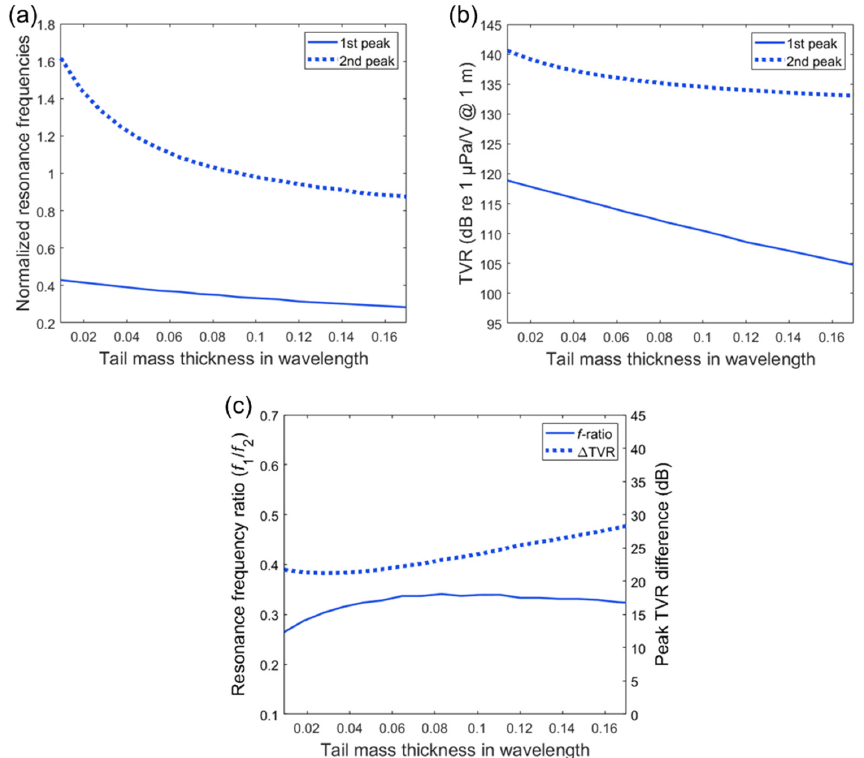
Figure 6. Transmitting characteristics as a function of the tail mass thickness. The thickness dimension is presented in wavelength and the frequency values are normalized by the fundamental longitudinal resonance frequency: ( a ) normalized resonance frequency variation; ( b ) TVR peak variation; ( c ) variation in resonance frequency ratio ( f 1 / f 2 ) and TVR difference.